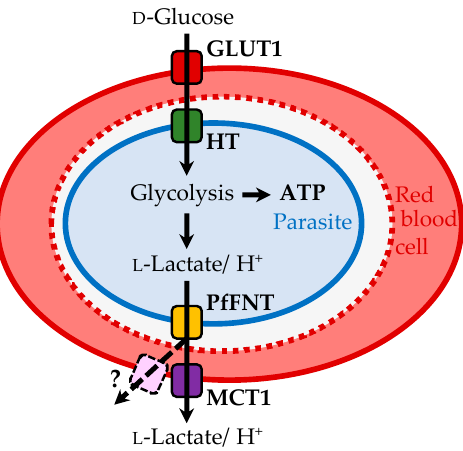
Figure 1. Energy flux in a P. falciparum -infected erythrocyte. Glucose is transported via the erythrocyte glucose transporter 1, GLUT1, and the hexose transporter, HT, into the parasite’s cytoplasm. Glycolysis generates ATP from glucose, forming the metabolic end products L -lactate and protons that are exported via PfFNT into the erythrocyte cytosol, and eventually by the human monocarboxylate transporter, MCT1, or alternative red cell export pathways.